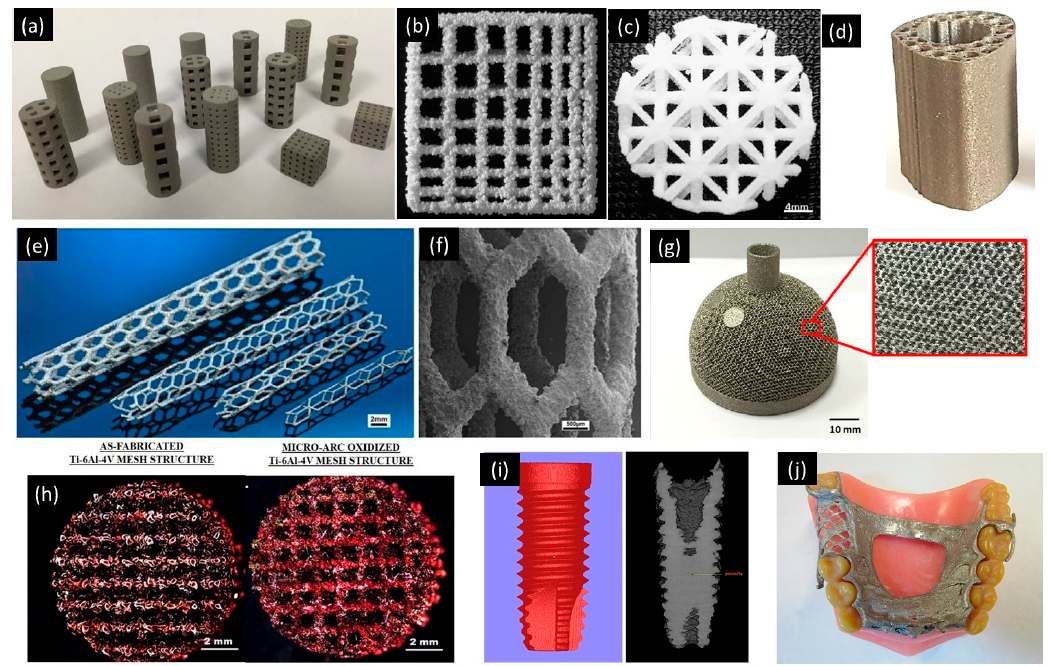
Figure 6. Examples of various powder-based 3D-printed scaffolds. ( a ) PBBJ 3D-printed specimens of various sizes, shapes and lattice structure designs. Reproduced with permission from [171]; ( b ) PBBJ 3D-printed grid structure with wall thickness of 330 µm. Reproduced with permission from [161]; ( c ) SLS 3D-printed polycaprolactone scaffold with pore size 40–400 µm. Reproduced with permission from [126]; ( d ) Ti–6Al–4V implant prototypes manufactured by direct metal laser sintering (DMLS). Reproduced with permission from [177]; ( e ) cardiovascular stents 3D-printed by SLM 3D-printing process. Reproduced with permission from [178]; ( f ) scanning electron microscope (SEM) image of cardiovascular stents. Reproduced with permission from [178]; ( g ) EBM 3D-printed porous acetabular cup implant. Reproduced with permission from [27]; ( h ) EBM 3D-printed mesh structures for intercellular cell communication and osteoincorporation. Reproduced with permission from [179]; ( i ) microcomputed tomography image of the Ti–6Al–4V dental implant 3D-printed by EBM 3D-printing process. Reproduced with permission from [180]; ( j ) sintered partial denture framework 3D-printed by PBBJ 3D-printing process. Reproduced with permission from [181].